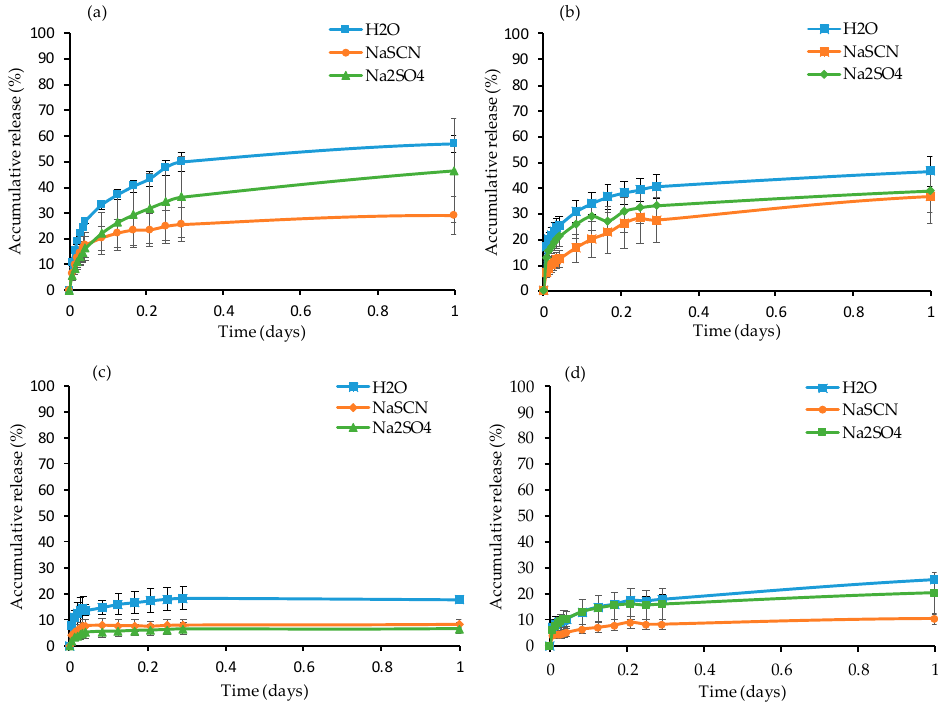
Figure 7. Accumulative release of fluorescein as a function of time from G2F at ( a ) room temperature and ( b ) 37 °C and from G2R at ( c ) room temperature and ( d ) 37 °C in water, 0.1 M NaSCN, and 0.1 M Na 2 SO 4 solution, respectively.